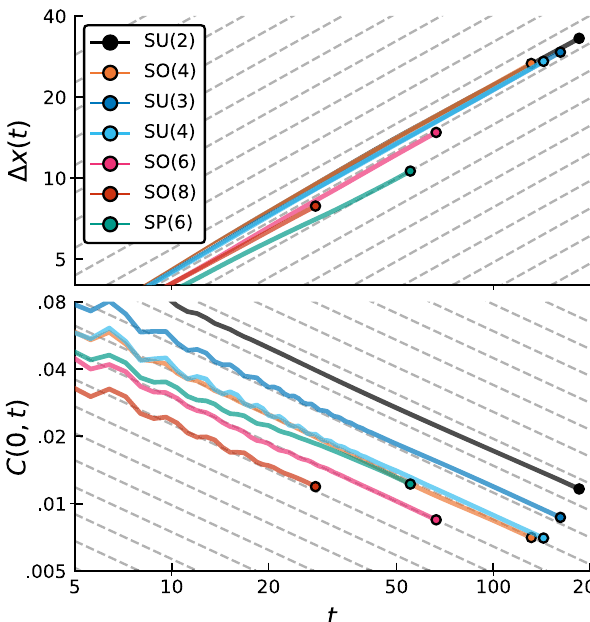
FIG. 2. Asymptotic charge correlator profiles rescaled using the dynamical exponent z ¼ 3 = 2 collapse. The highlighted region shows the KPZ scaling function for a range of widths fit to these profiles — the fit fails, as the tails of the scaling function appear to fall off faster than in KPZ scaling. The inset shows the same plot with a linear